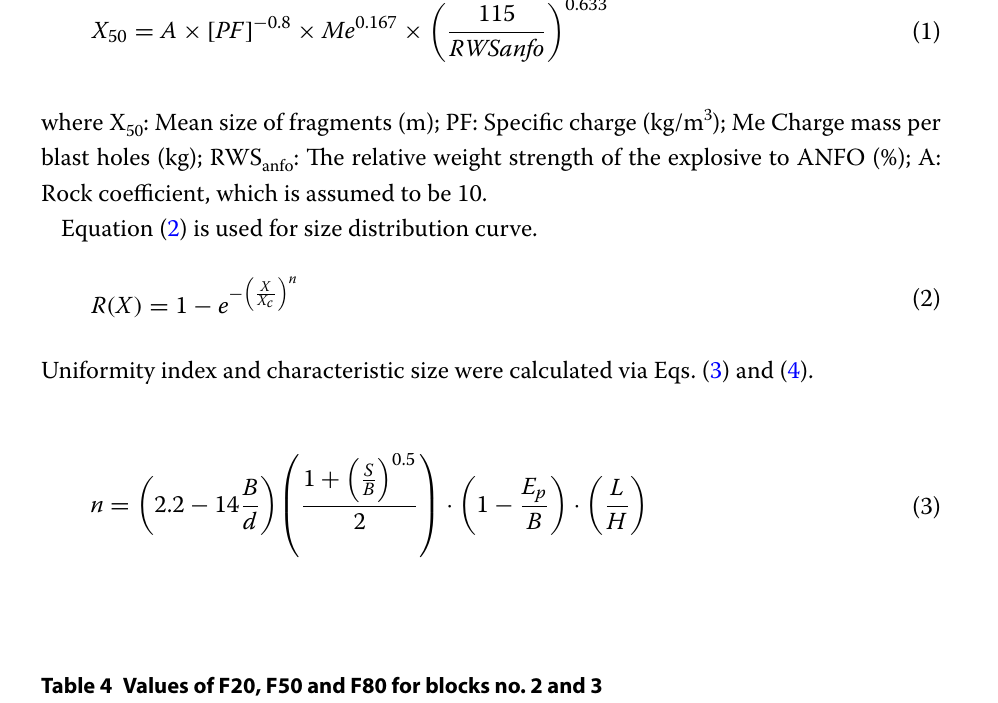
Table 4 Values of F20, F50 and F80 for blocks no. 2 and 3 Percent passing Block no. 2 Block no. 3 F 20 132.57 181.31 F 80 297.51 412.99 F 80 568.15